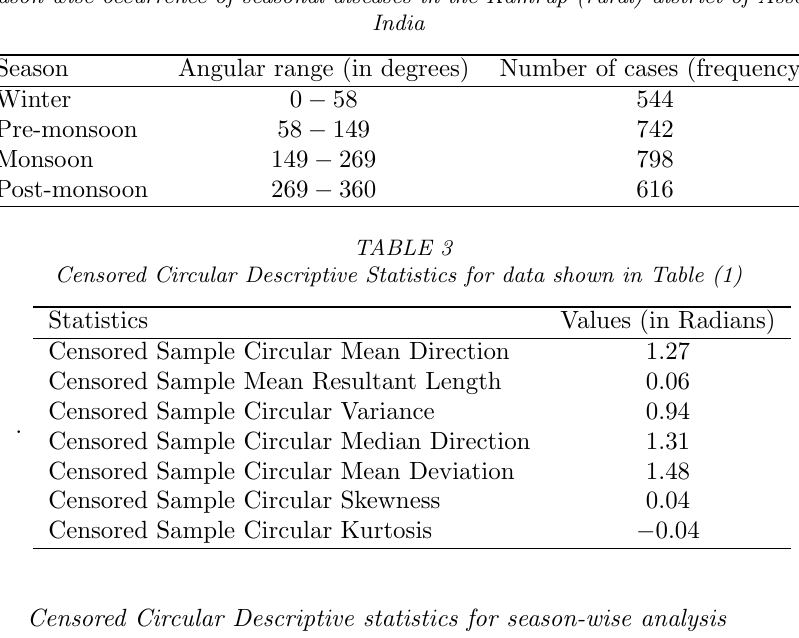
Season-wise occurrence of seasonal diseases in the Kamrup (rural) district of Assam,